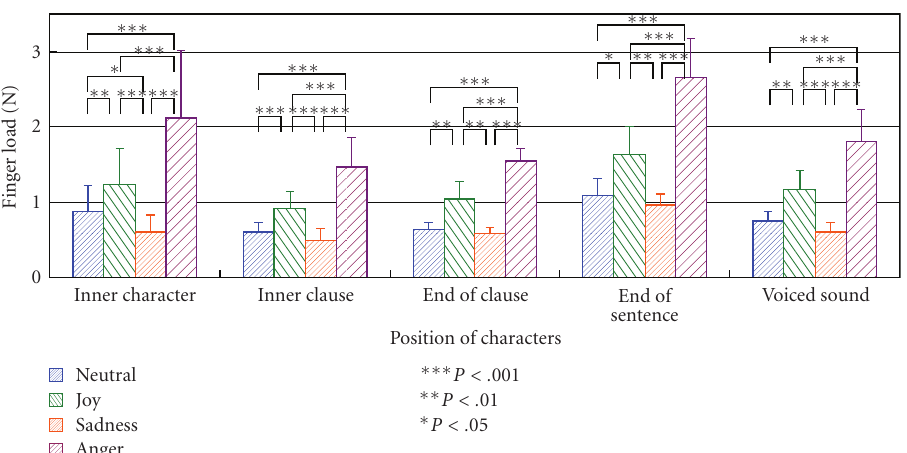
Figure 18: Mean of finger load as a function of emotions and position of characters for one-handed Finger Braille (error bars represent standard